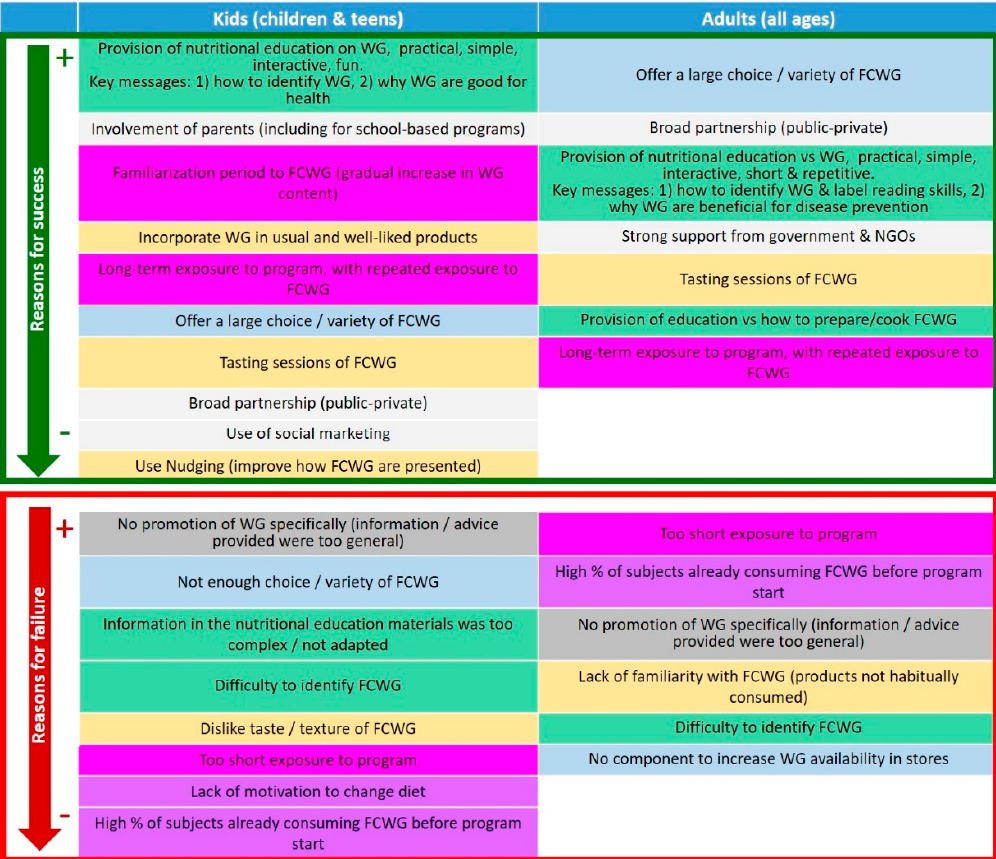
Figure 4. Main reasons for success or failure of programs that aimed at promoting whole grain consumption in children and adults, as identified from the data that were collected in the frame of the current review. Factors are presented in decreasing order of their possible importance (from + to − ), for each age group separately, on the basis of the number of studies that have concluded that the corresponding factor was a reason for success or failure. NGOs: non-governmental organizations; WG: whole grain. FCWG, foods containing WG.